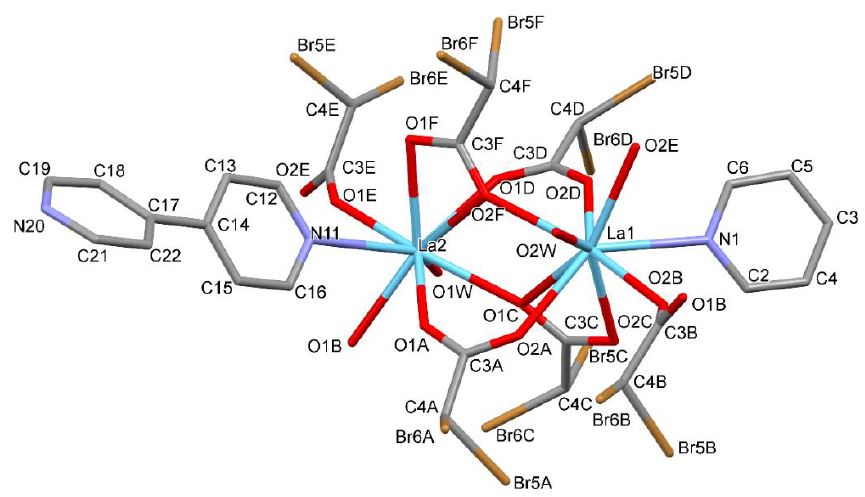
Figure 2. The molecular structure of the complex with La(III) (compound 1) showing the atom-labelling schemes.